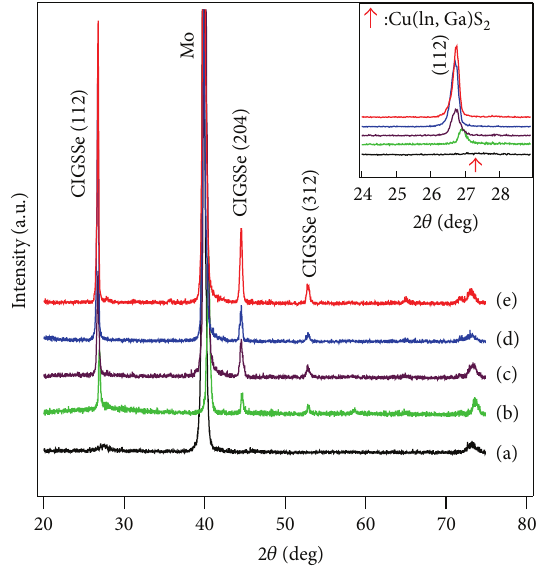
Figure 2: XRD pattern of CIGS/Mo without (a) and with annealing at temperatures of 500 (b), 520 (c), 540 (d), and 560 ∘ C (e) for 30 min under a selenium vapor ambience. The inset shows the 𝑥 - axis magnified peaks from 24 ∘ to 30 ∘ . The arrow is the position of Cu(In,Ga)S 2 (112)